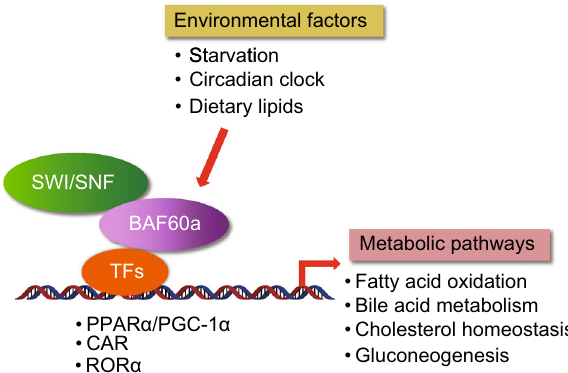
Figure 1. Metabolic regulation by BAF60a in liver. Hepatic BAF60a senses and integrates the environmental factors, such as starvation, circadian clock, and dietary fat consumption, to transcriptional reprogramming and metabolic adaptations, through its direct interaction with speci fi c transcriptional fac- tors/cofactors and SWI/SNF-mediated